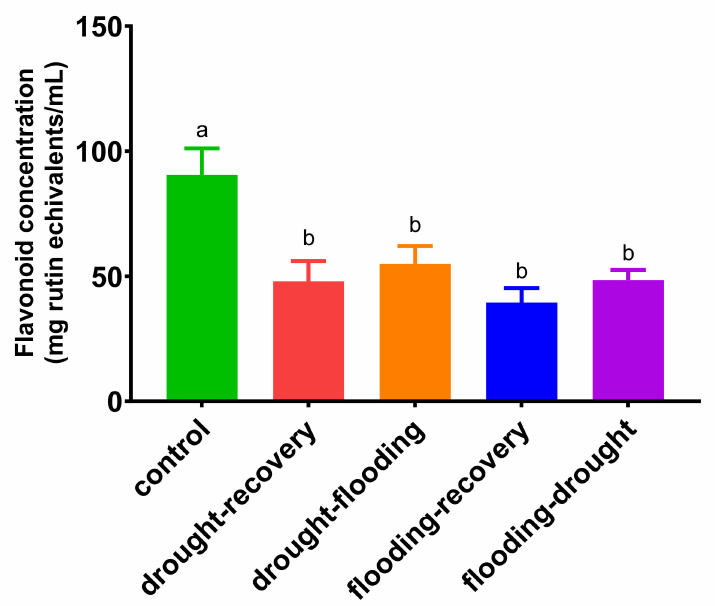
Figure 5. Total flavonoid concentration in O. basilicum leaves under different stress